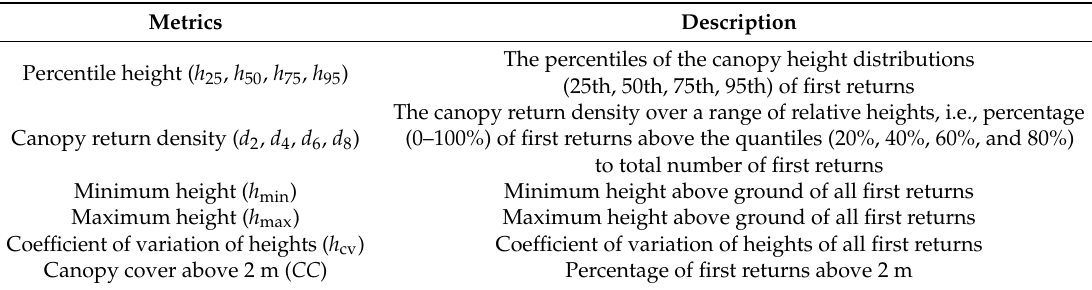
Table 4. Summary of LiDAR metrics computed from point